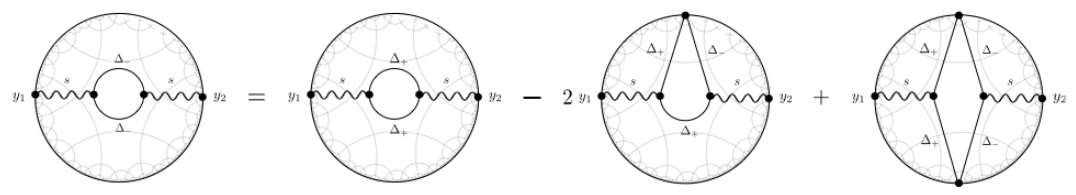
Figure 9b. For bubble diagrams with two scalars propagating in the loop, diagrams with di(cid:11)erent conformal boundary conditions on the scalar (cid:12)elds di(cid:11)er by both a single and double cut of the internal